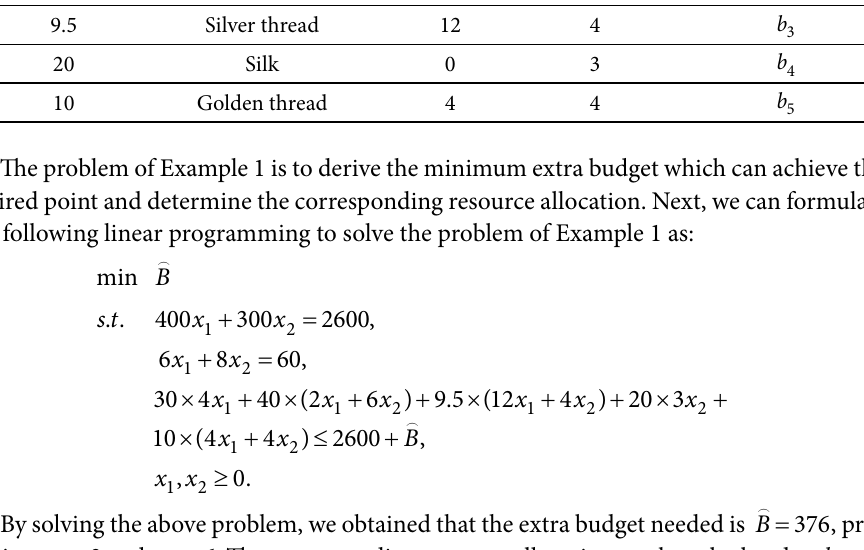
Table 3. Information table for Example 1 Unit price Resource